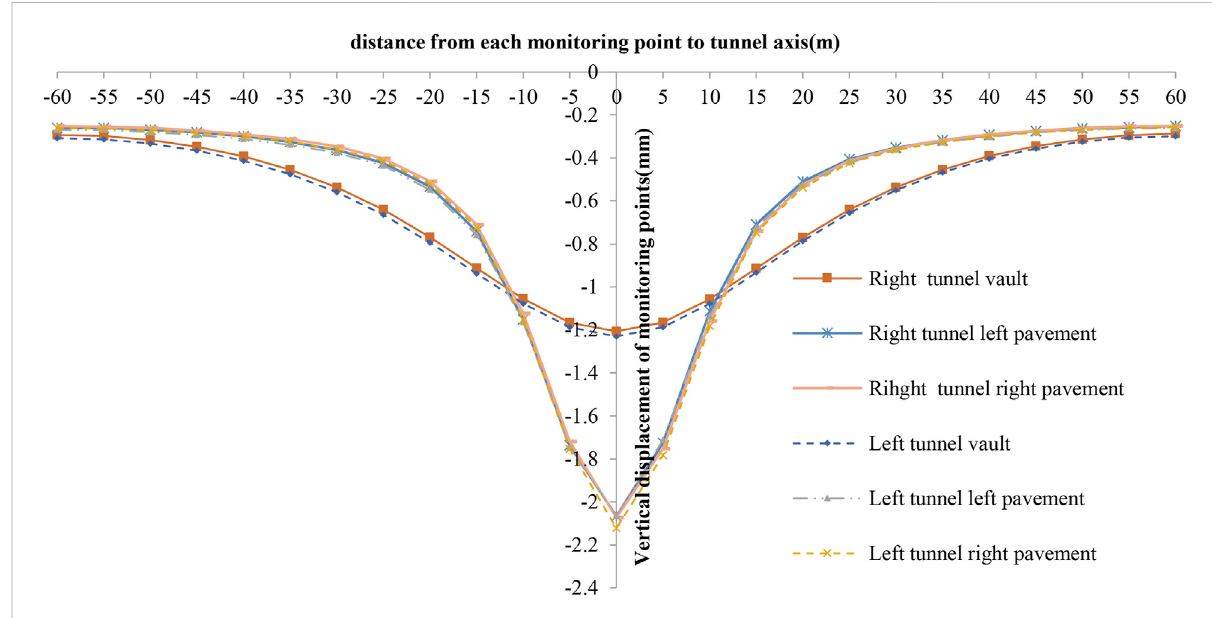
FIGURE 7 Vertical displacement through the rear tunnel monitoring